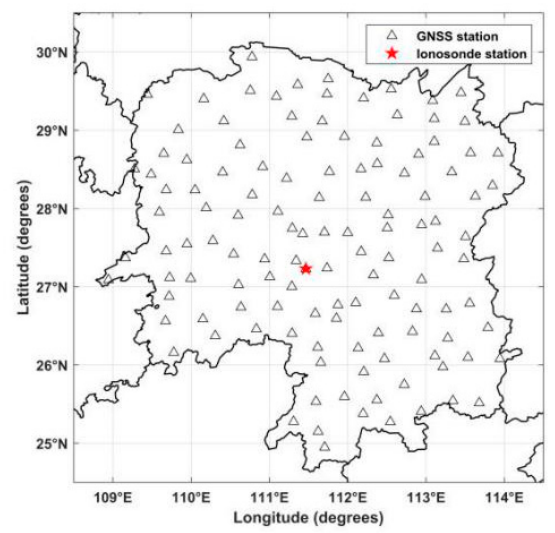
Figure 2. Distribution of the continuously operating reference network GNSS stations and ionosonde station in Hunan province.